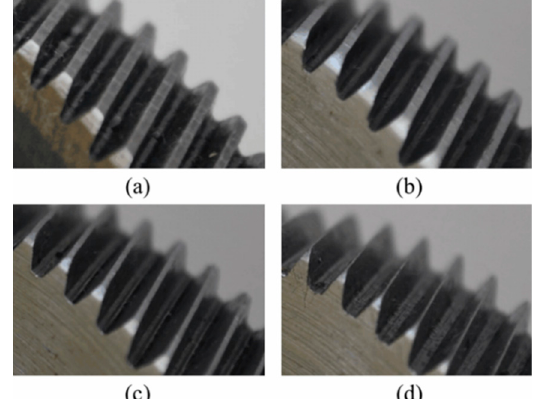
Figure 4. Proposed study cases for evaluating the gear in the gearbox: ( a ) HTL; ( b ) 25%, ( c ) 50%, and ( d ) 75% of uniform wear in the gears.